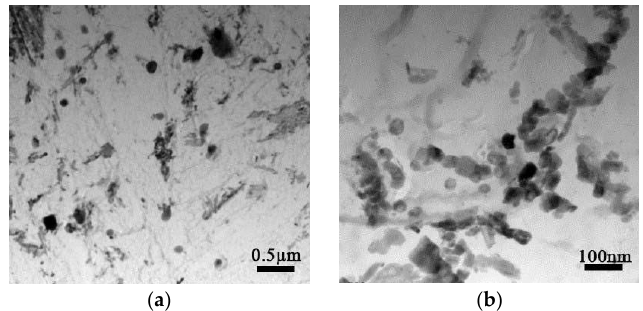
Figure 7. Distribution of carbides at the half-radius of the H13 ingot after tempering. ( a ) Large field of view; ( b ) Small field of view.